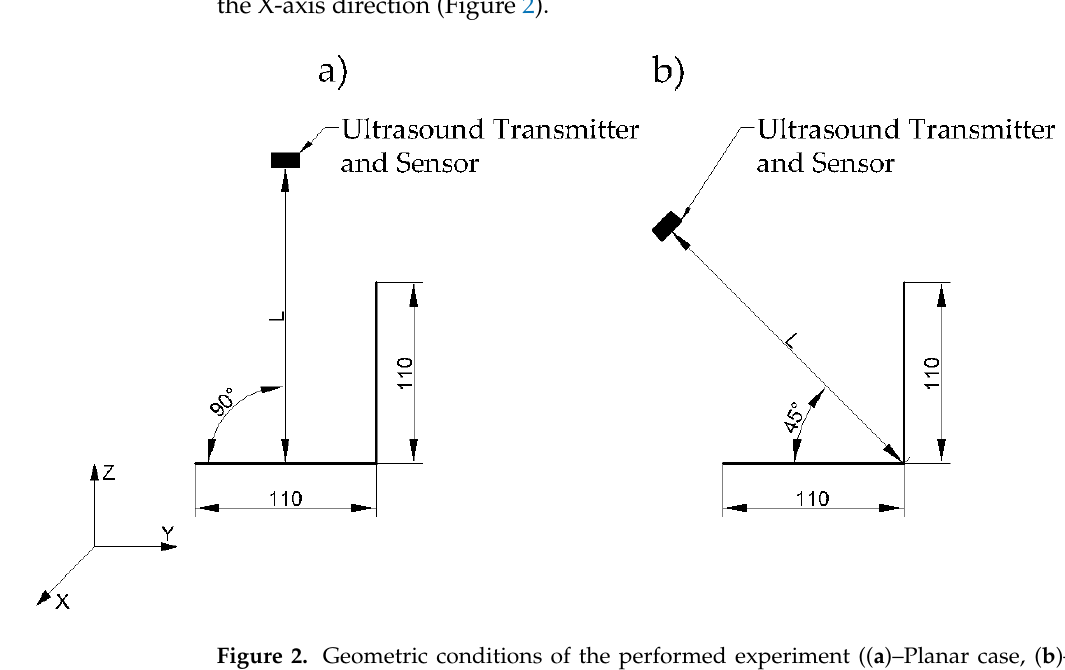
Figure 2. Geometric conditions of the performed experiment (( a )–Planar case, ( b )–Corner case, L–measured distance vector, all dimensions are in millimeters).